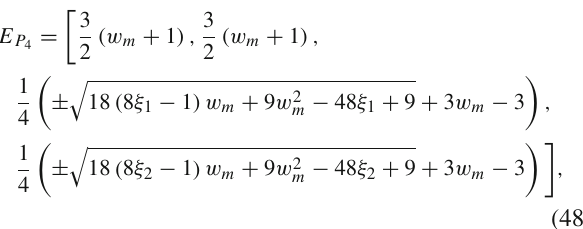
showing that in the dust case (w m = 0 ) the P 4 solution has a saddle dynamical